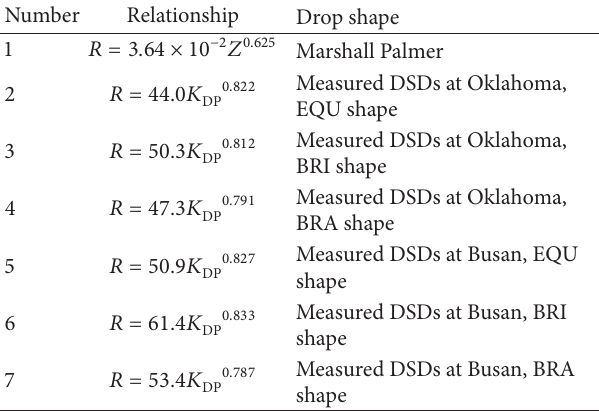
Table 2: List of different relations used for